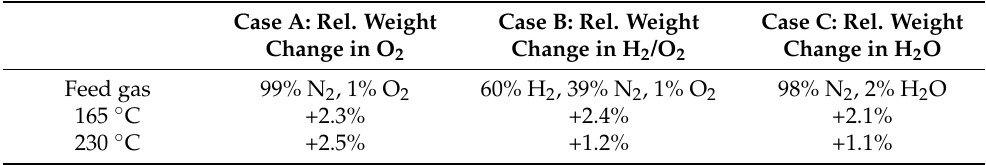
= 0–10 bar, p N = 0–10 bar; p O = 0–0.1 2 2 2